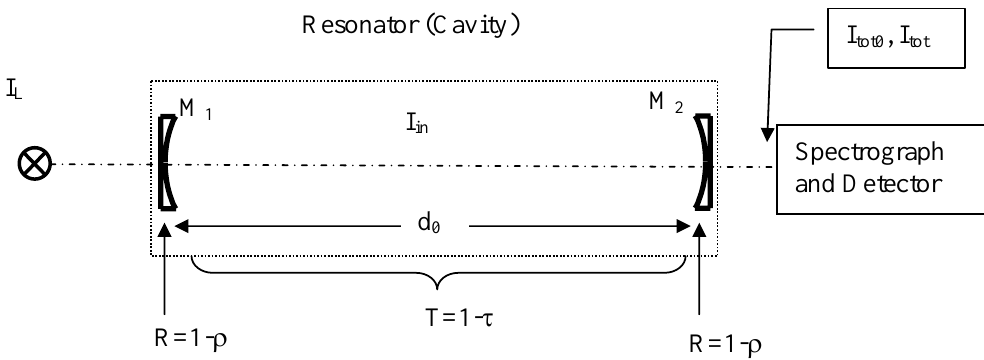
Fig. 2. Sketch of CEAS set-up. The optical resonator is formed by two concave mirrors M 1 and M 2 , both with the same reflectivity R = 1 − ρ . The transmission factor for one traverse through the cavity is T = 1 − τ =1 − εd 0 . The intensity of the radiation emitted by the source is I L (transfer optics between light source and resonator is not shown).